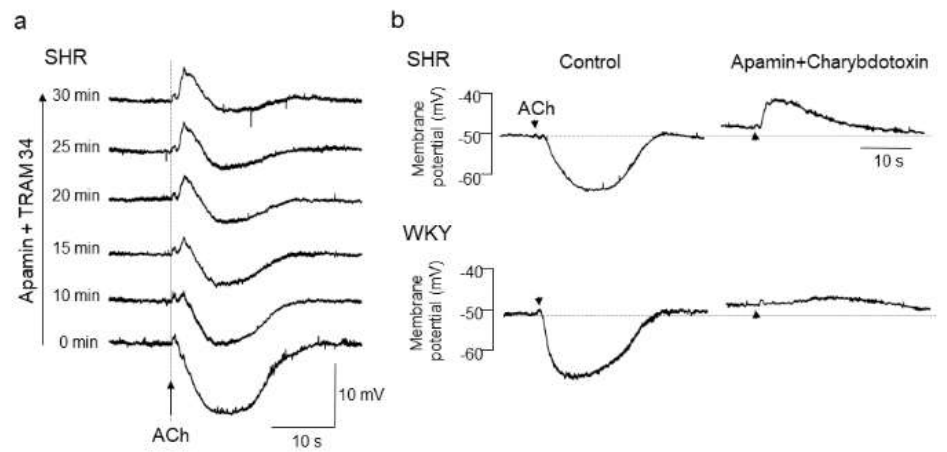
Figure 1. Acetylcholine (ACh)-evoked depolarization in mesenteric arteries of spontaneously hypertensive rats (SHRs). ( a ) A hidden depolarization emerged after blockade of endothelium-dependent hyperpolarization (EDH) with apamin (0.5 µ mol/L, a small-conductance Ca 2+ -sensitive K + channel (K Ca ) inhibitor) plus TRAM34 (100 nmol/ L, an intermediate-conductance K Ca inhibitor) in mesenteric arteries of SHRs. All recordings were from the same cell. ( b ) ACh-evoked depolarization in the presence of apamin (0.5 μmol/L) plus charybdotoxin (60 nmol/ L, a large and intermediate-conductance K Ca inhibitor) was larger in amplitude and faster in time course in SHRs than in Wistar Kyoto (WKY) rats. Each paired recording was from the same preparation. Indomethacin (10 μmol/L) and N ω -nitro-L-arginine methyl ester (100 μmol/L) were present throughout. Arrows, application of ACh. Modified from Goto et al. [87].